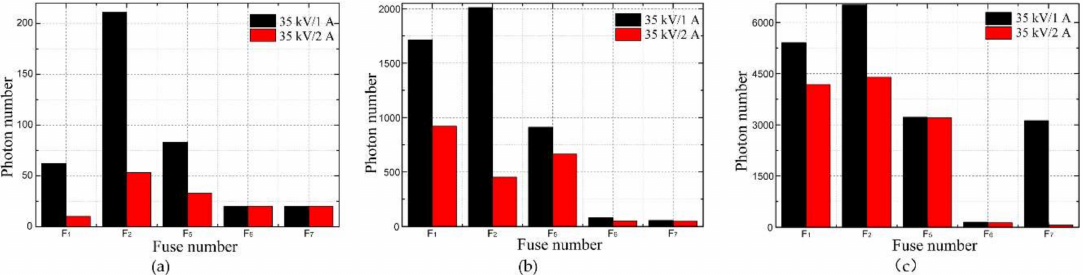
Figure 18. Number of photons measured for each sample of fuses. ( a ) 10 kV; ( b ) 20 kV; ( c ) 30